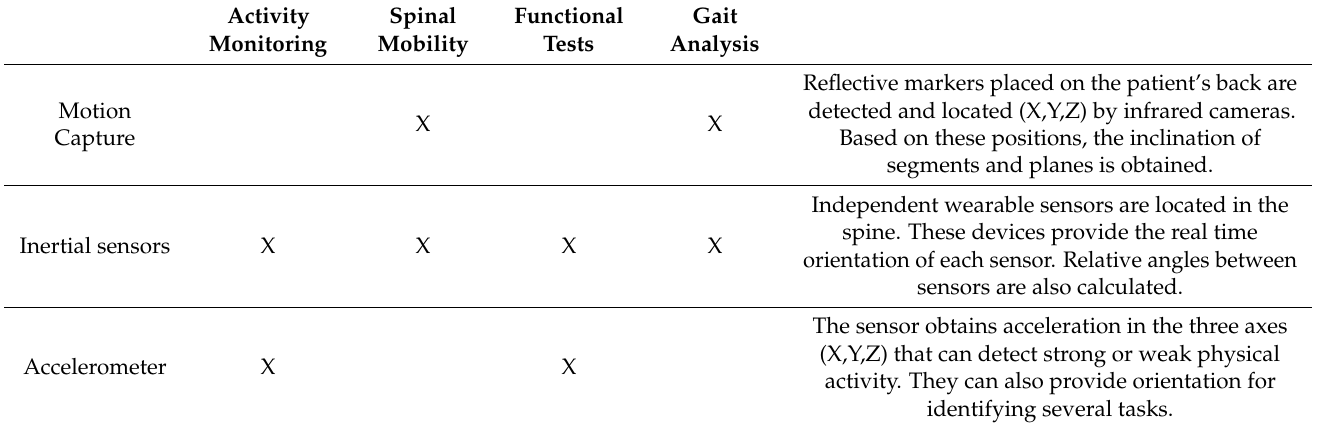
Table 1. Technical alternatives to assess patient mobility in